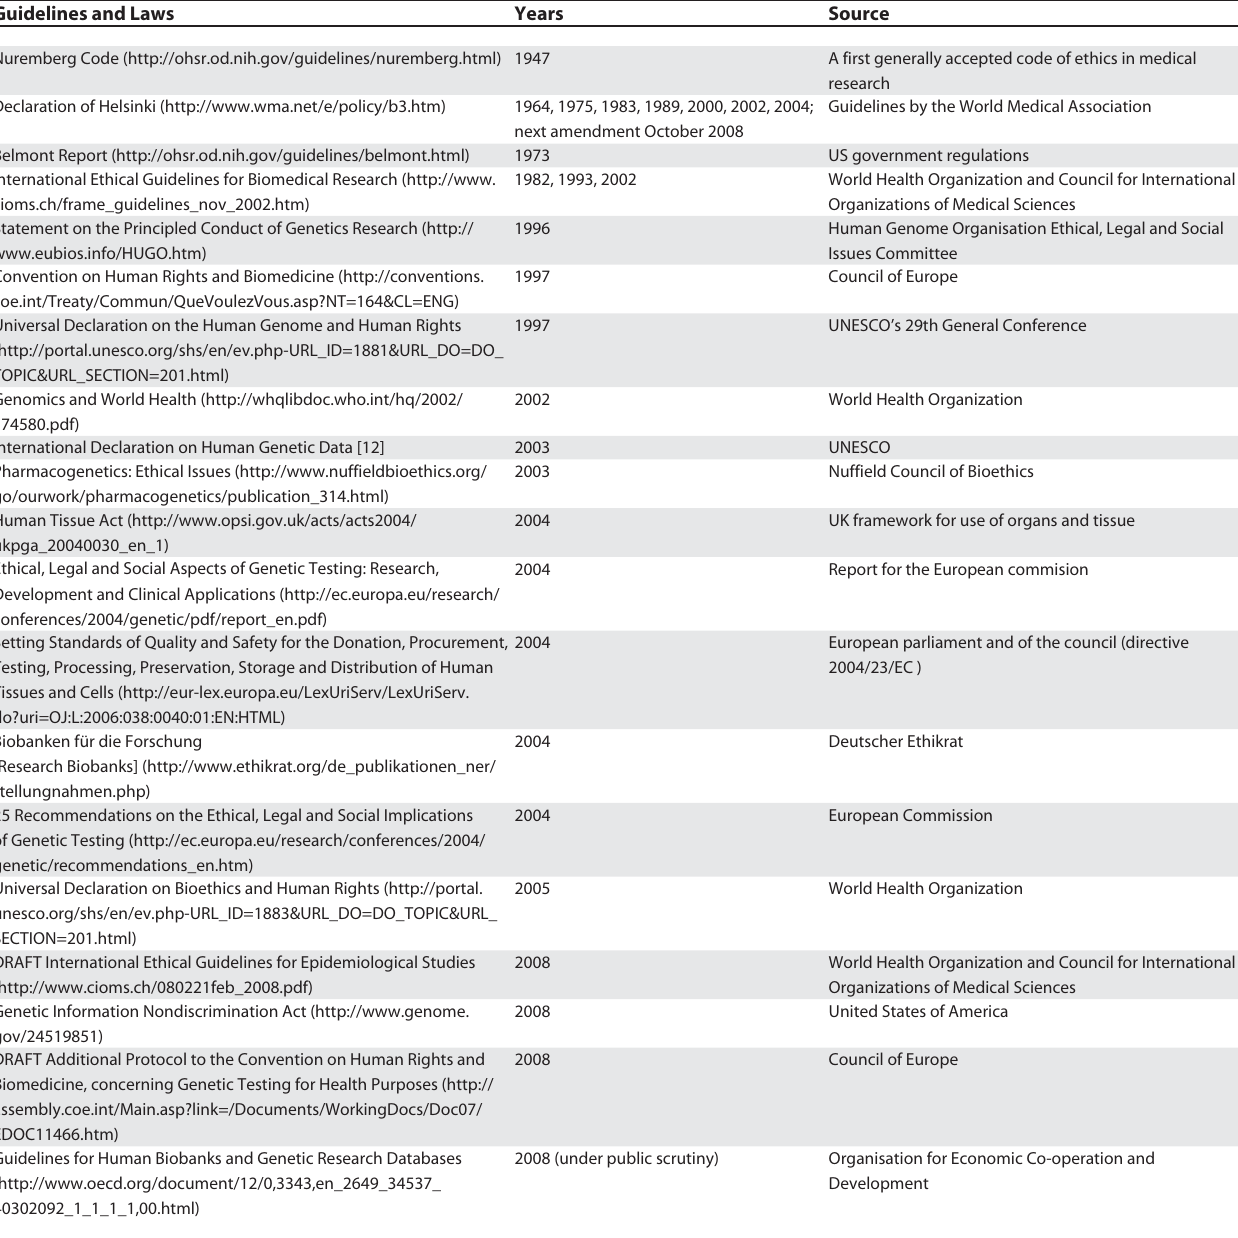
Table 1. History: From an Early Informed Consent Proposal to Modern Recommendations for Genetic